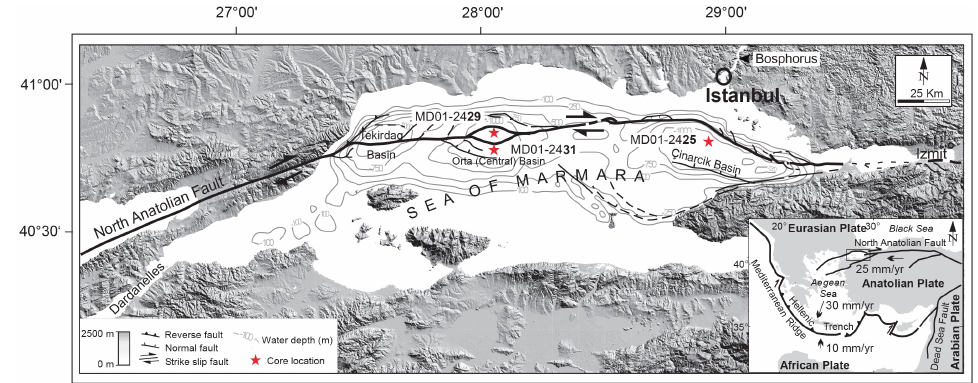
Figure 1. The Sea of Marmara and the North Anatolian Fault: simplified bathymetry and active structures. Location of analyzed core. NAF geometry simplified from Armijo et al. (2002, 2005), and GPS kinematics from McClusky et al. (2000) and Reilinger et al.